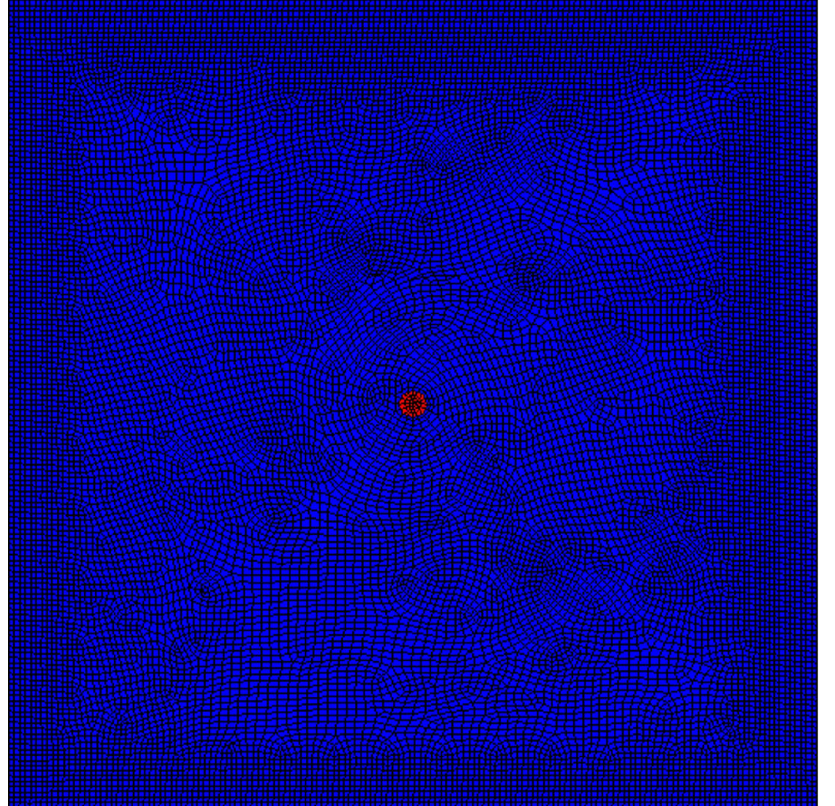
Fig 3. Mohr-Coulomb constitutive model of the homogeneous circular